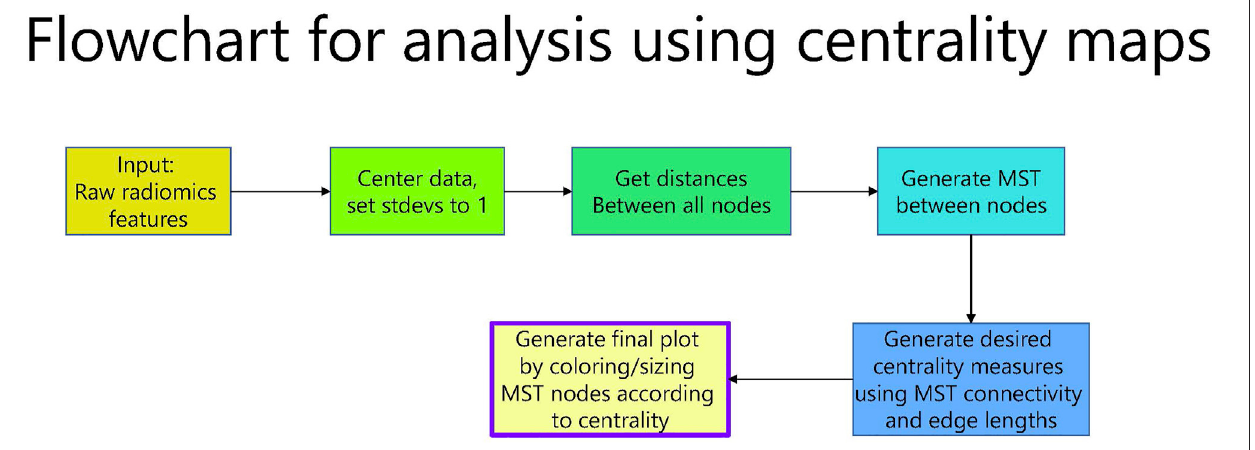
FIGURE 1 | Flowchart for analysis using centrality maps.